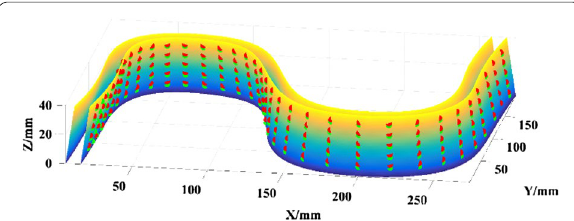
Figure 5 The theoretical points and average measuring